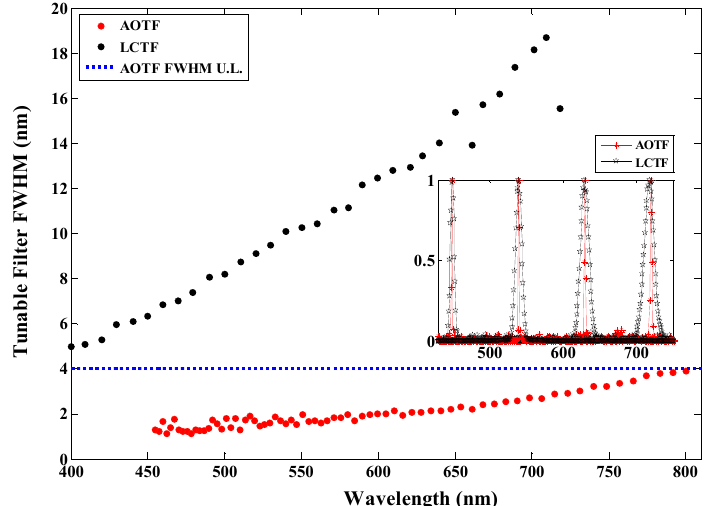
Figure 7. The imager’s spectral resolution evaluation in the case of switching between AOTF (red circles) and liquid crystal tunable filter (LCTF, black circles) along the wavelength operating range for each filter. Samples of filtered/diffracted bands are also included in the embedded figure. A blue dotted horizontal line is drawn with a value equal to the lower spectral resolution limit of the AOTF-HSI. This line illustrates that the AOTF has superior linewidth in contrast with the highest spectral resolution of the corresponding LCTF-HSI.